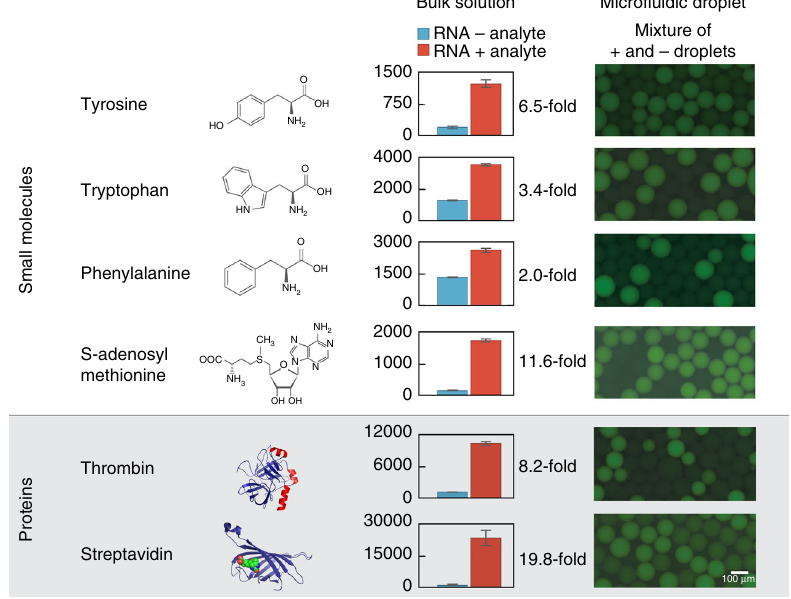
Fig. 2 Establishing a panel of Spinach-based aptamers that can detect analytes in droplets. A panel of Spinach-based aptamer sensors was tested across a variety of small molecule and protein targets. Aptamers were synthesized through in vitro transcription and incubated with or without the analyte of interest, and fl uorescence was measured. Bar graphs represent the mean of three replicates ( error bars depict s.d.). On the right, solutions of dye with RNA aptamer or with both RNA aptamer and analyte were encapsulated and the resulting microdroplets were imaged using fl uorescence microscopy. The negative (RNA alone) and positive (RNA and analyte) droplets were mixed together for simultaneous imaging of contrast. All images were acquired under the same magni fi cation, and representative images from multiple independent trial runs are depicted. Sequences of all aptamers used in this study can